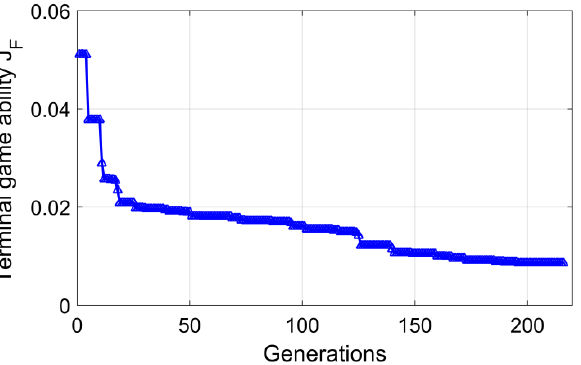
Figure 6. The variation of the pursuer’s terminal game ability J F with generations for GA optimization.